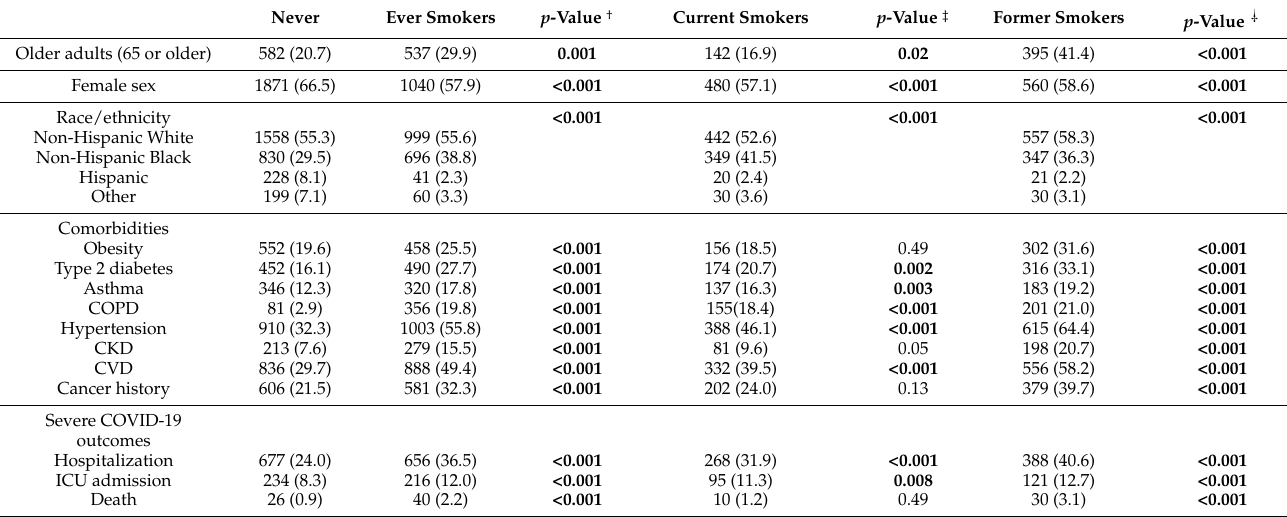
Abbreviations: COPD: chronic obstructive pulmonary disease; CKD: chronic kidney disease; CVD: cardiovascular disease; ICU: intensive care unit. † p -values comparing characteristics between current or former smokers and never smokers. ‡ p -values comparing characteristics between current smokers and never smokers.